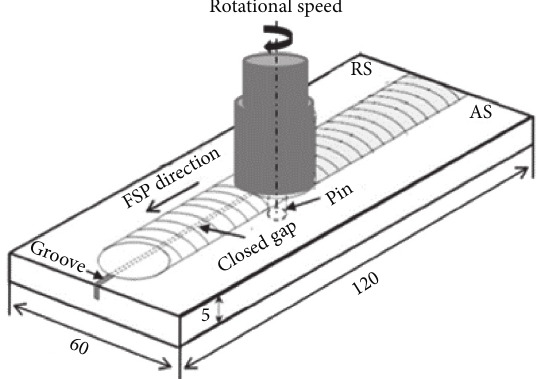
Figure 2: Schematic illustration of the process of FSP